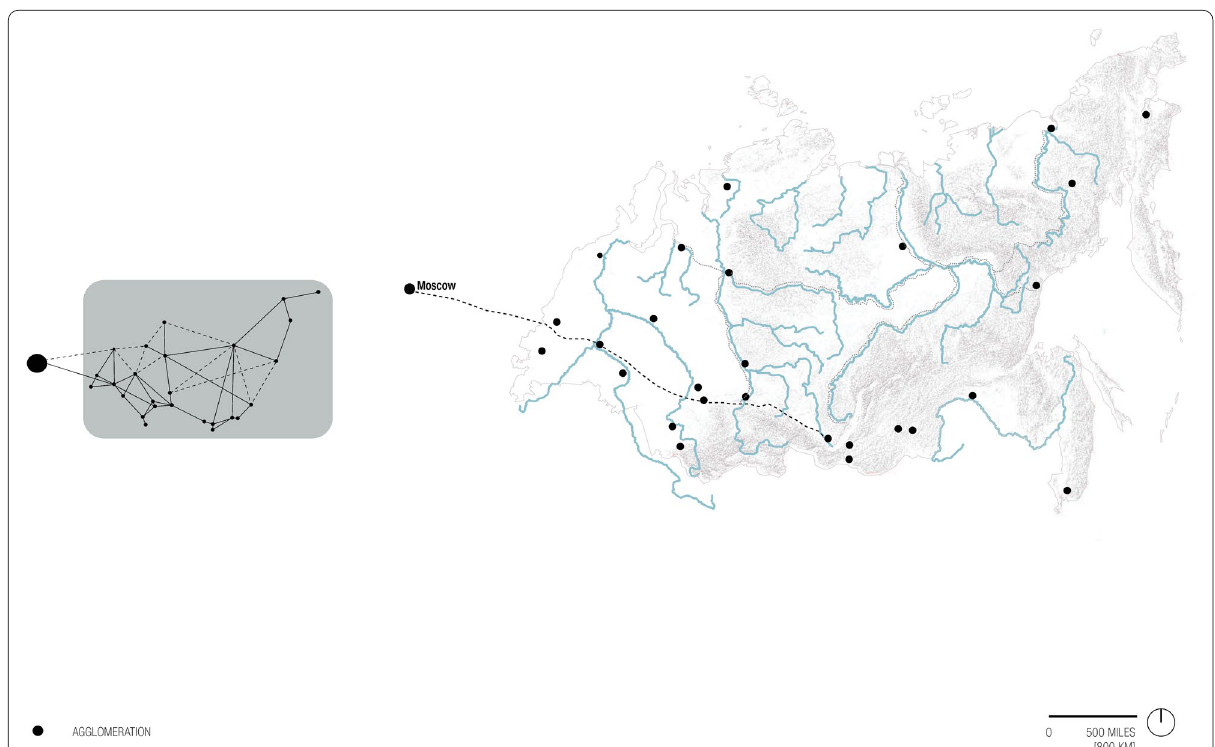
Fig. 1 Siberia: First spatial regime, showing new towns and the system of fluvial connectivity. Image credits: Salgueiro Barrio and O’Shea. Image Sources:Drawing 1:Cities: Naumov I V (2006) The history of Siberia. London: Routledge,